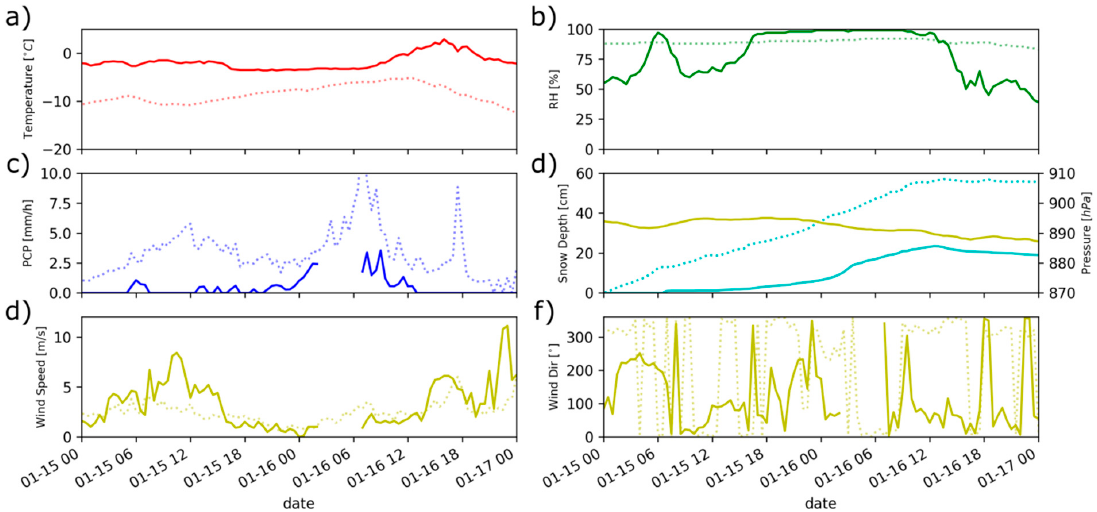
Figure 5. Automatic weather station network (AWS) observations from Das (solid line) and Malniu (dotted line) of ( a ) temperature, ( b ) relative humidity, ( c ) precipitation rate, ( d ) snow depth (blue lines) and surface pressure (in Das only; yellow line), ( e ) wind speed and ( f ) wind direction. Dates are indicated considering the format MM-DD HH (month-day hour) in UTC.